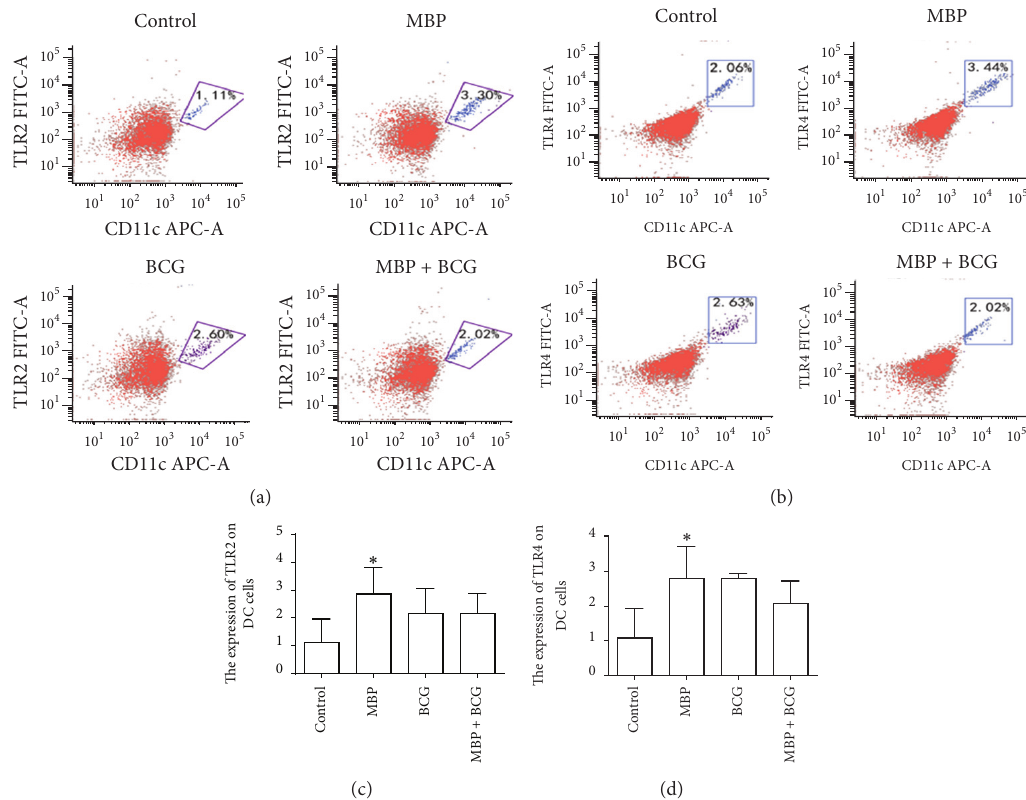
Figure 3: MBP upregulates the surface expression of TLR2/TLR4 on DCs. (a-b) TLR2/TLR4 surface molecule expression in DCs is shown in flow cytometry dot plots. (c-d) The percentage of CD11c + cells expressing surface TLR2/TLR4 is shown in a data table. All data are expressed as the mean ± standard deviation from three independent experiments. ∗ 𝑃 < 0.05 compared with control